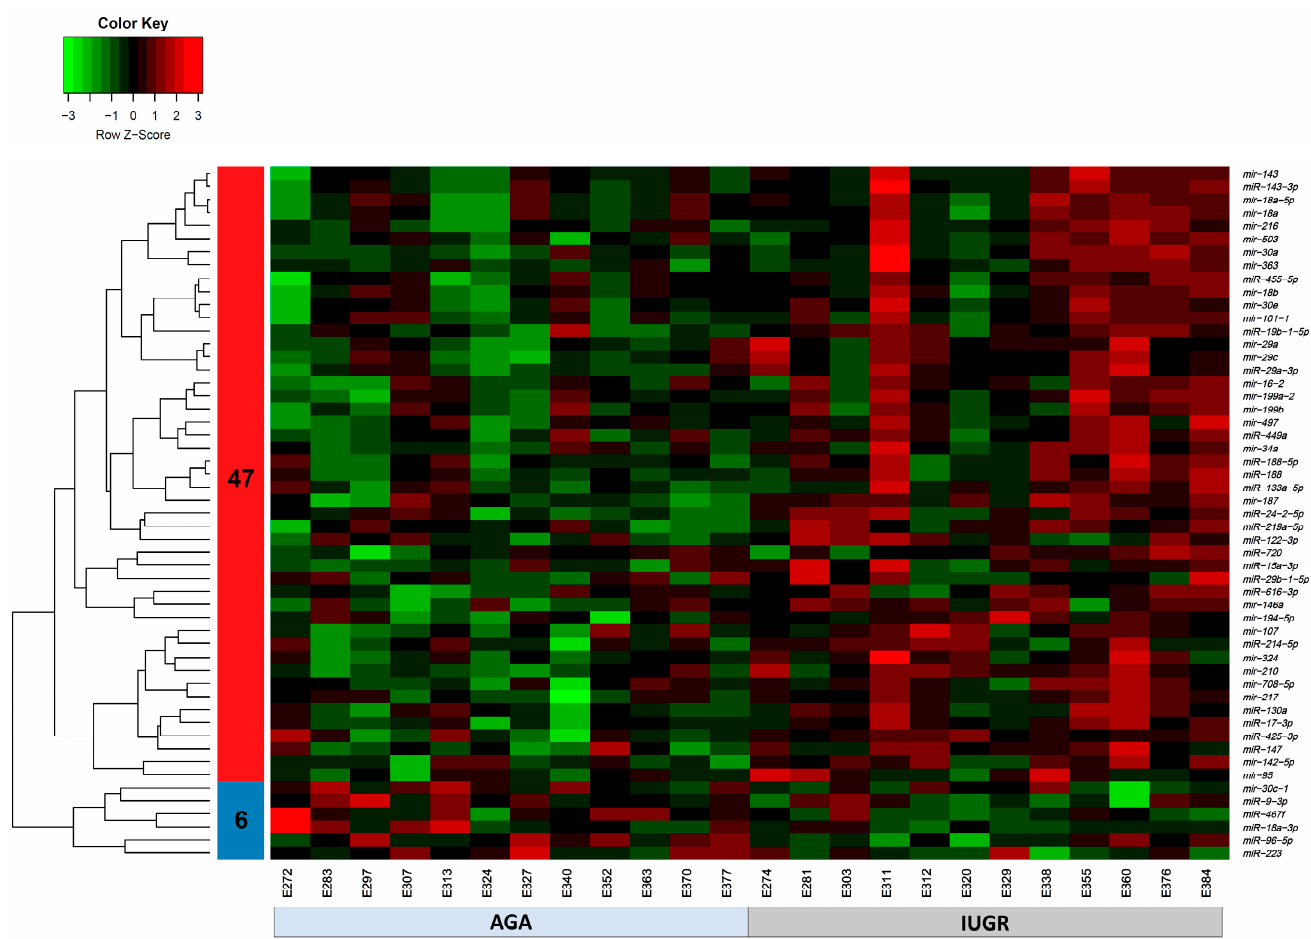
Figure 2. Heatmap of differentially expressed miRNAs ( p < 0.05) in AGA and IUGR groups. Heatmap of miRNAs expression profiles was generated using the hierarchical clustering method of heatmap.2 function of gPlots (version 3.0.1) [53] Bioconductor Package in the R Programming environment (version 4.0.3). Forty-seven miRNAs in cluster 1 were upregulated and six miRNAs in cluster 2 were downregulated in LDM from IUGR compared to AGA fetuses. Upregulated miRNAs are marked in red, downregulated miRNAs are colored in green, and black color reflects no difference in expression levels.